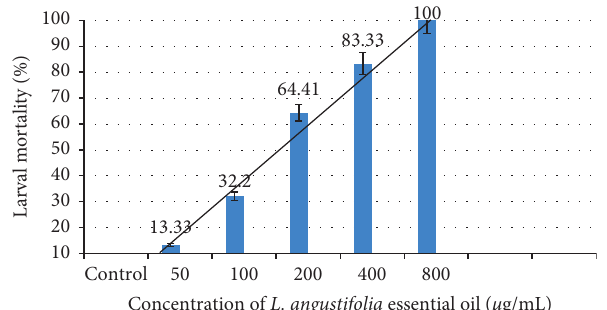
Figure 1: Mortality rate (%) of Culex pipiens larvae according to the concentrations of L. angustifolia subsp. E. Oil after 24h of